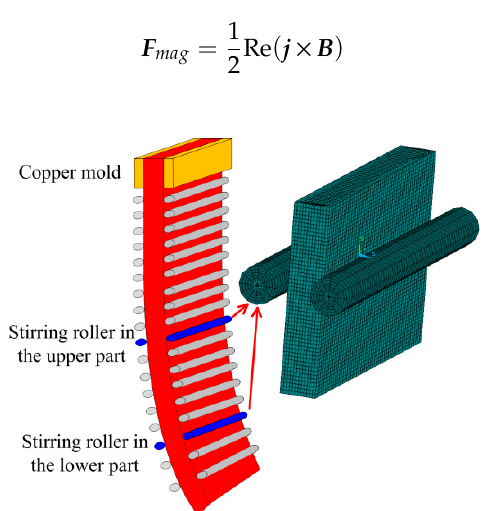
Figure 1. Schematic diagram of secondary electromagnetic stirring (S-EMS) in the continuous casting slab.